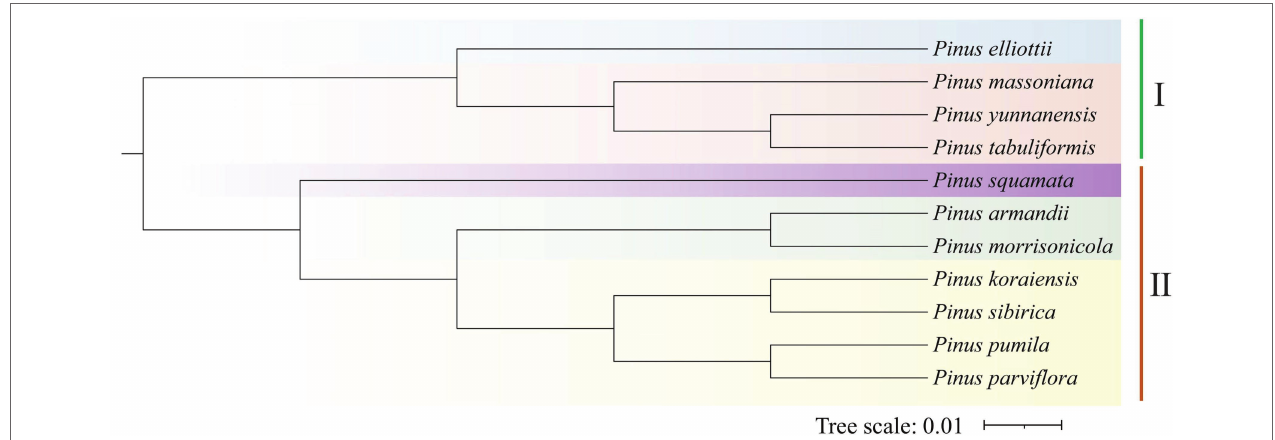
FIGURE 6 | Phylogenetic relationships of Pinus koraiensis , Pinus sibirica , Pinus pumila , and eight other Pinus species. A phylogenetic tree of all 11 Pinus species was constructed based on orthologous genes. Two subsections of Pinus species are listed with Roman numerals. I represents the subsection Pinus for the two/ three-needle pines. II indicates the subsection Strobus for the five-needle